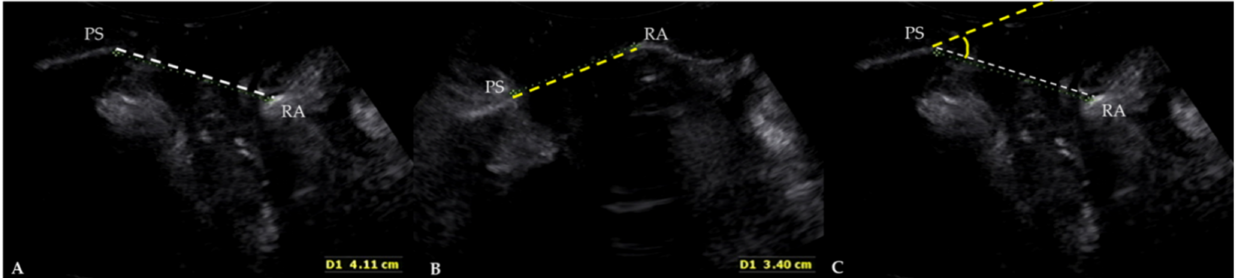
Figure 2. Translabial ultrasonography in patients with pelvic organ prolapse (POP) at rest ( A ), and in the maximal Valsalva phase ( B ). PS: pubis symphysis; RA: rectal ampulla. We measured the angle between a reference line through the inferior margin of the symphysis pubis and the levator plate connected to the rectal ampulla, at rest (white dotted line) and during the Valsalva maneuver (yellow dotted line) ( C ). A quantitative value was used to express the difference in the angle between a horizontal reference line through the inferior margin of the symphysis pubis and the levator plate connected to the rectal ampulla, between rest and during the Valsalva